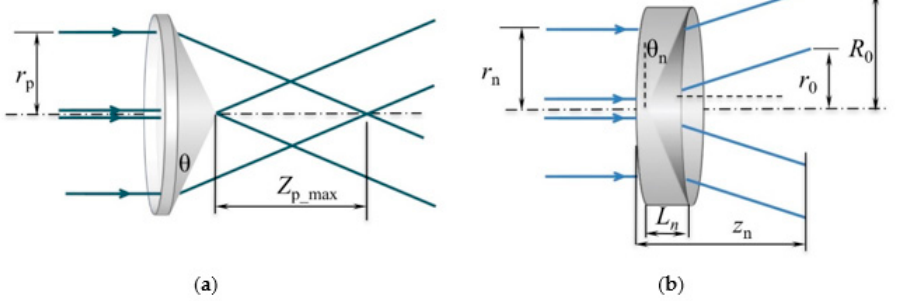
Figure 1. The principle of a real axicon: ( a ) positive axicon, ( b ) negative axicon.